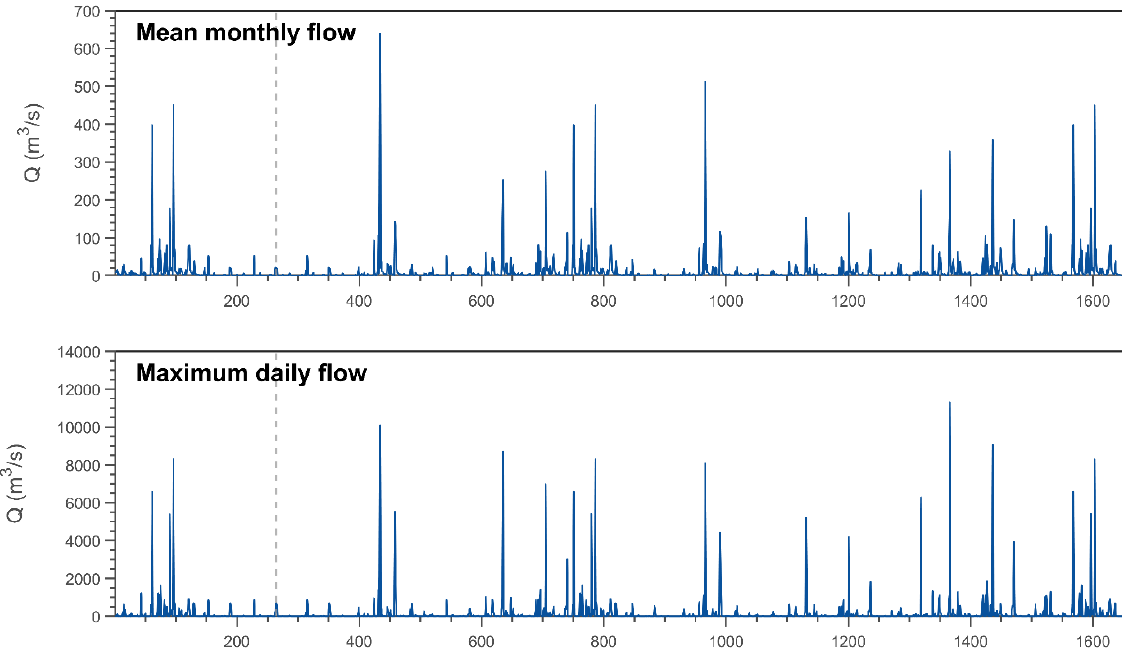
Figure A7. Mean monthly (top) and maximum daily (bottom) synthetic inflow hydrographs of additional scenario #5. The dashed line indicates the construction of the Wivenhoe Dam.